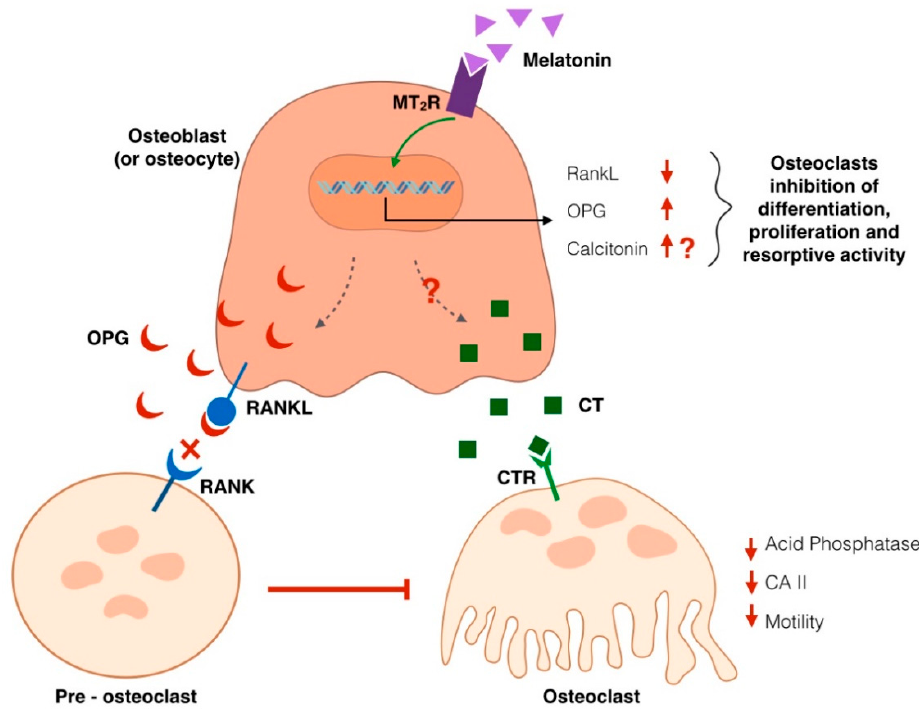
Figure 2. Molecular mechanism proposed for melatonin’s antiresorptive effect on bone density. Melatonin binding to its G-protein coupled receptor (MT2R), located on the cell membrane of osteoblasts/osteocytes and mesenchymal cells, induces a signaling cascade culminating in the modulation of genes that influence osteoclast differentiation and activity; specifically, a downregulation of RANKL and upregulation of osteoprotegerin (OPG), a decoy receptor produced by stromal cells as negative feedback to control osteoclastogenesis. Melatonin has also been proposed to produce an upregulation of calcitonin, whose binding to its receptor (calcitonin binding receptor or CTR) on osteoclasts induces a rapid cell contraction, causes inhibition of osteoclast motility. Calcitonin also inhibits (red arrows) other pathways associated with osteoclast activity, such as the release of acid phosphatase and the expression of carbonic anhydrase II (CA II), a cytosolic enzyme involved in the maintenance of an acidic environment, necessary for osteoclast